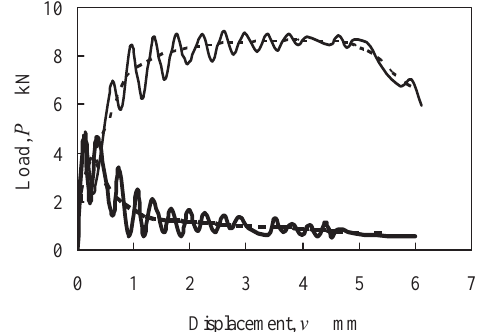
Fig.5. Superimposed P - v records and the smoothed curves of fatigue pre-cracked (lower curve) and U-notched (upper curve) specimens of SC material tested at a transition temperature of 313 K (40 (cid:864)